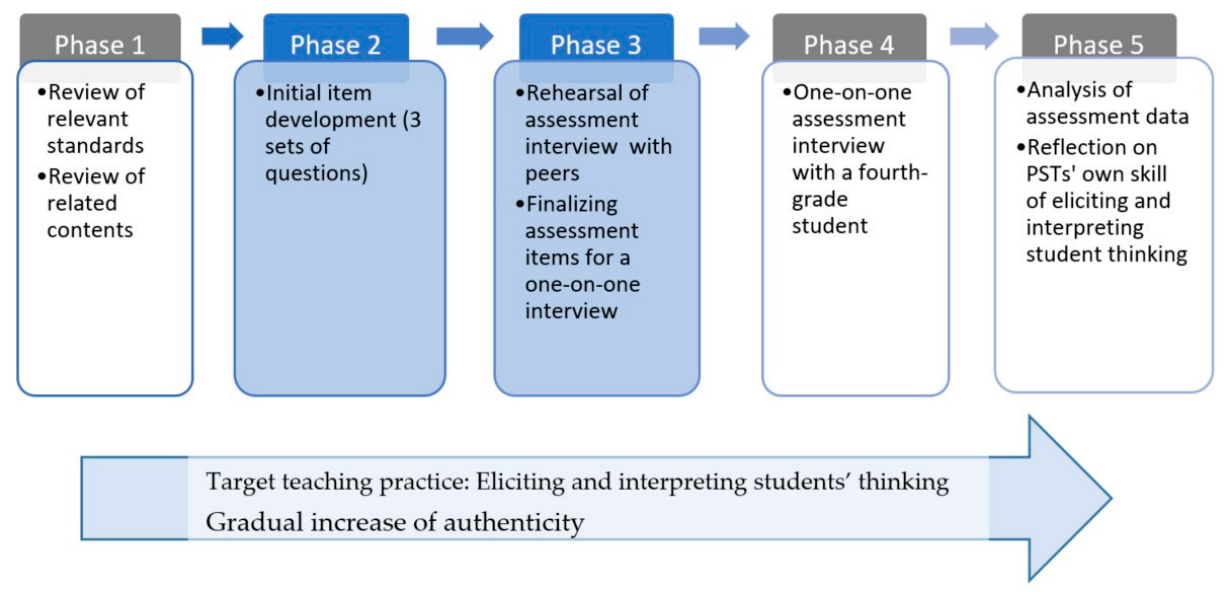
Figure 2. One-on-one assessment development progression.